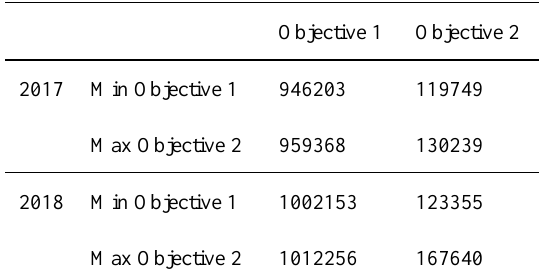
Table 5. Payoff table of 2017 and 2018 for unit-based target.